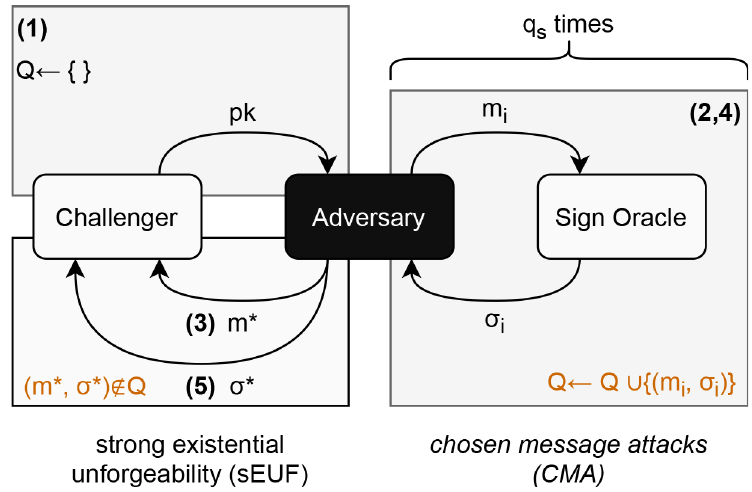
Figure 4. sEUF-CMA security